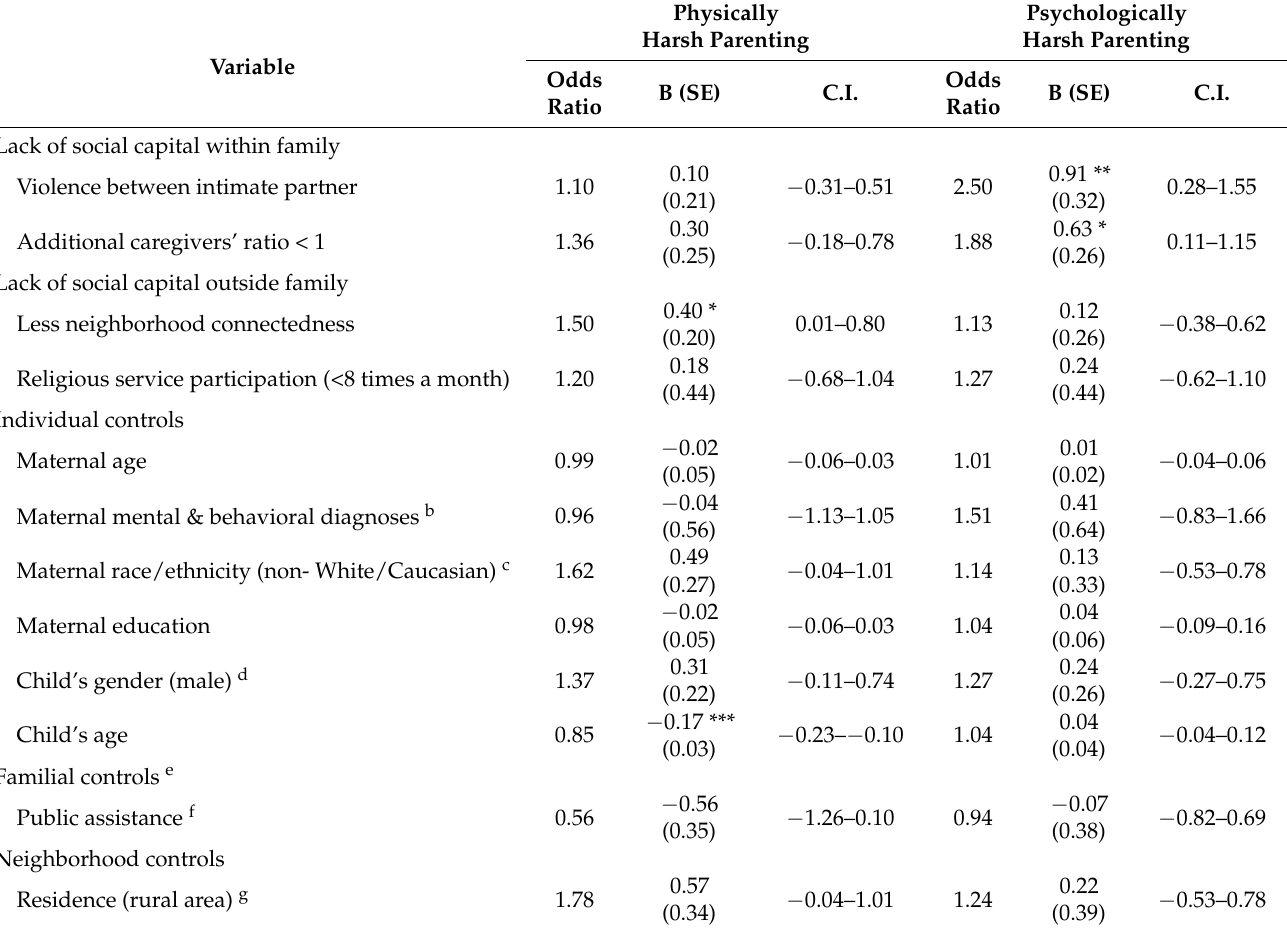
Harsh Parenting